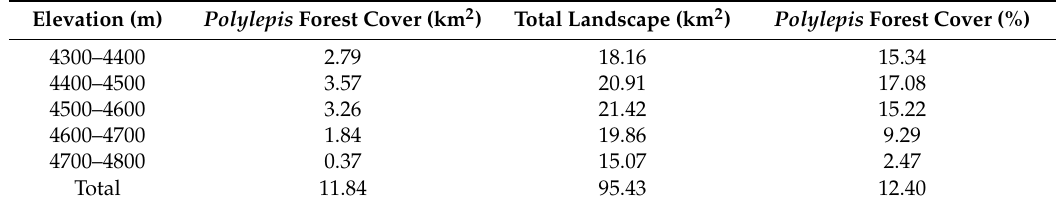
Table 2. Polylepis subsericans forest cover in five elevational belts in the study area of a 95-km 2 in the Andes of Southern Peru. The area is calculated based on 30 m × 30 m pixels assigned as